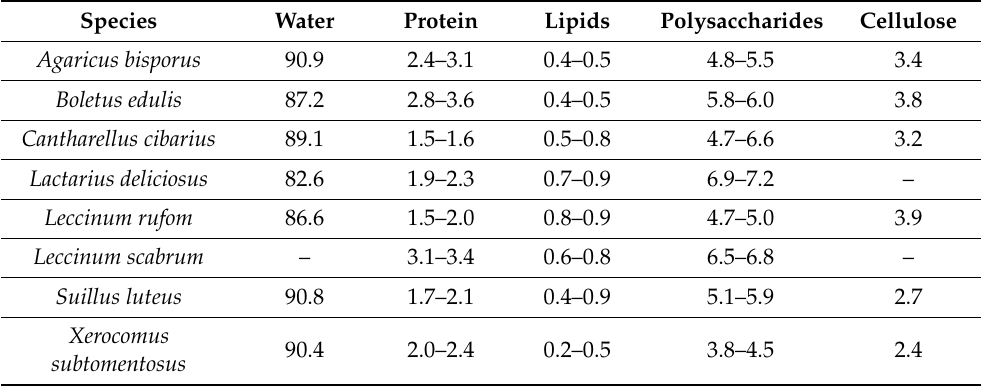
Table 1. Biologically active compounds extracted from fungi from Poland in g/100 g of edible parts